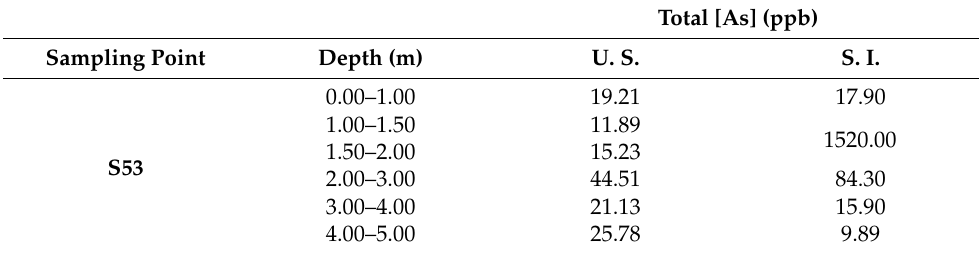
Table 2. Comparison between the results relating to the determination of the total As reported by Sviluppo Italia (S. I.) and to the survey carried out by the University of Salento (U. S.), in the sampling point